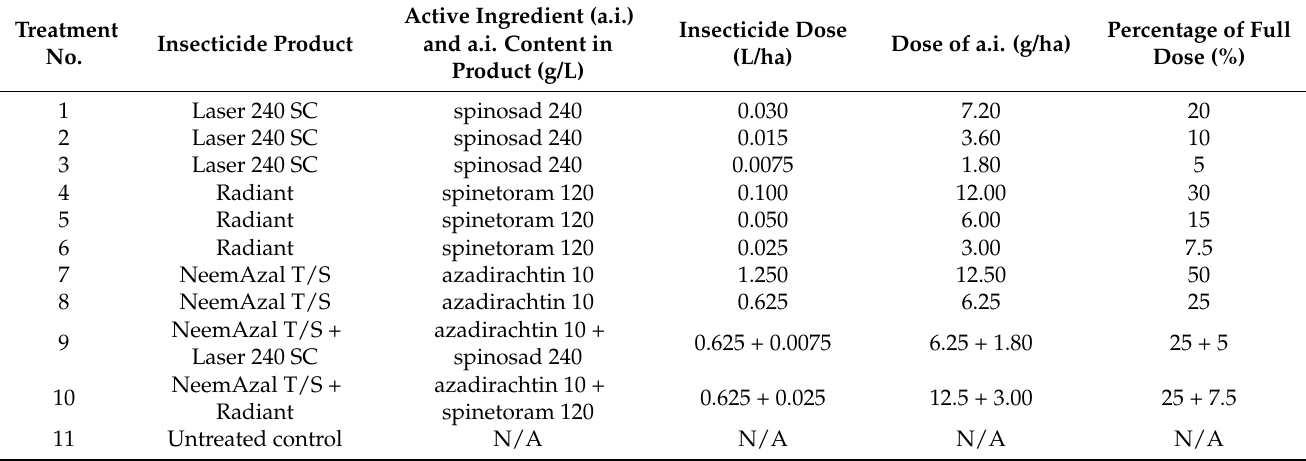
Table 1. Insecticidal treatments used against Colorado potato beetle larvae in the laboratory trial, Zagreb, 2019. Treatment Insecticide No.